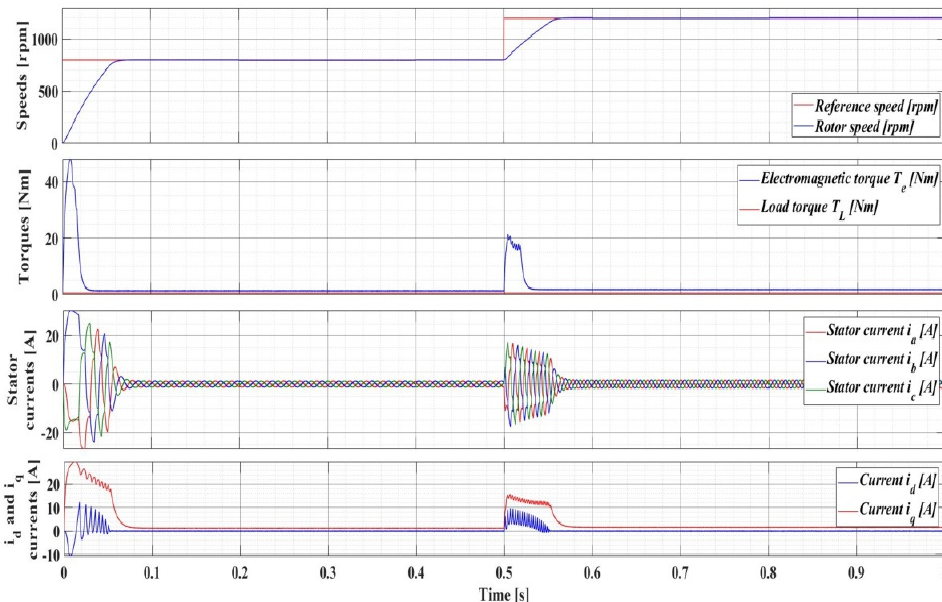
Figure 14. Time evolution parameters for PMSM control system based on FOC-type strategy for PMSM variable structure with switching signal type 1, ω ref = [800, 1200] rpm, and T L = 0.5 Nm.